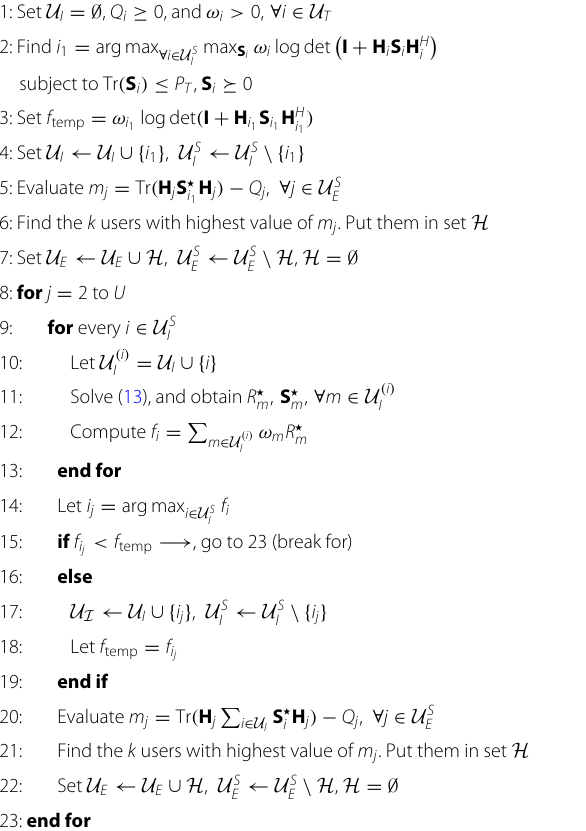
Table 6 Algorithm to jointly obtain the set of information and harvesting users U I , U